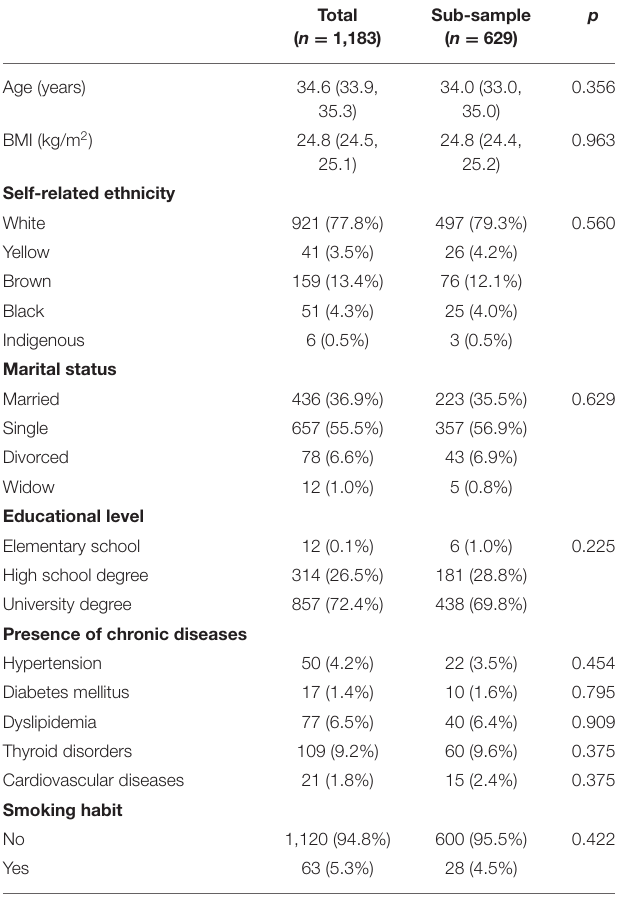
TABLE 1 | General characteristics of